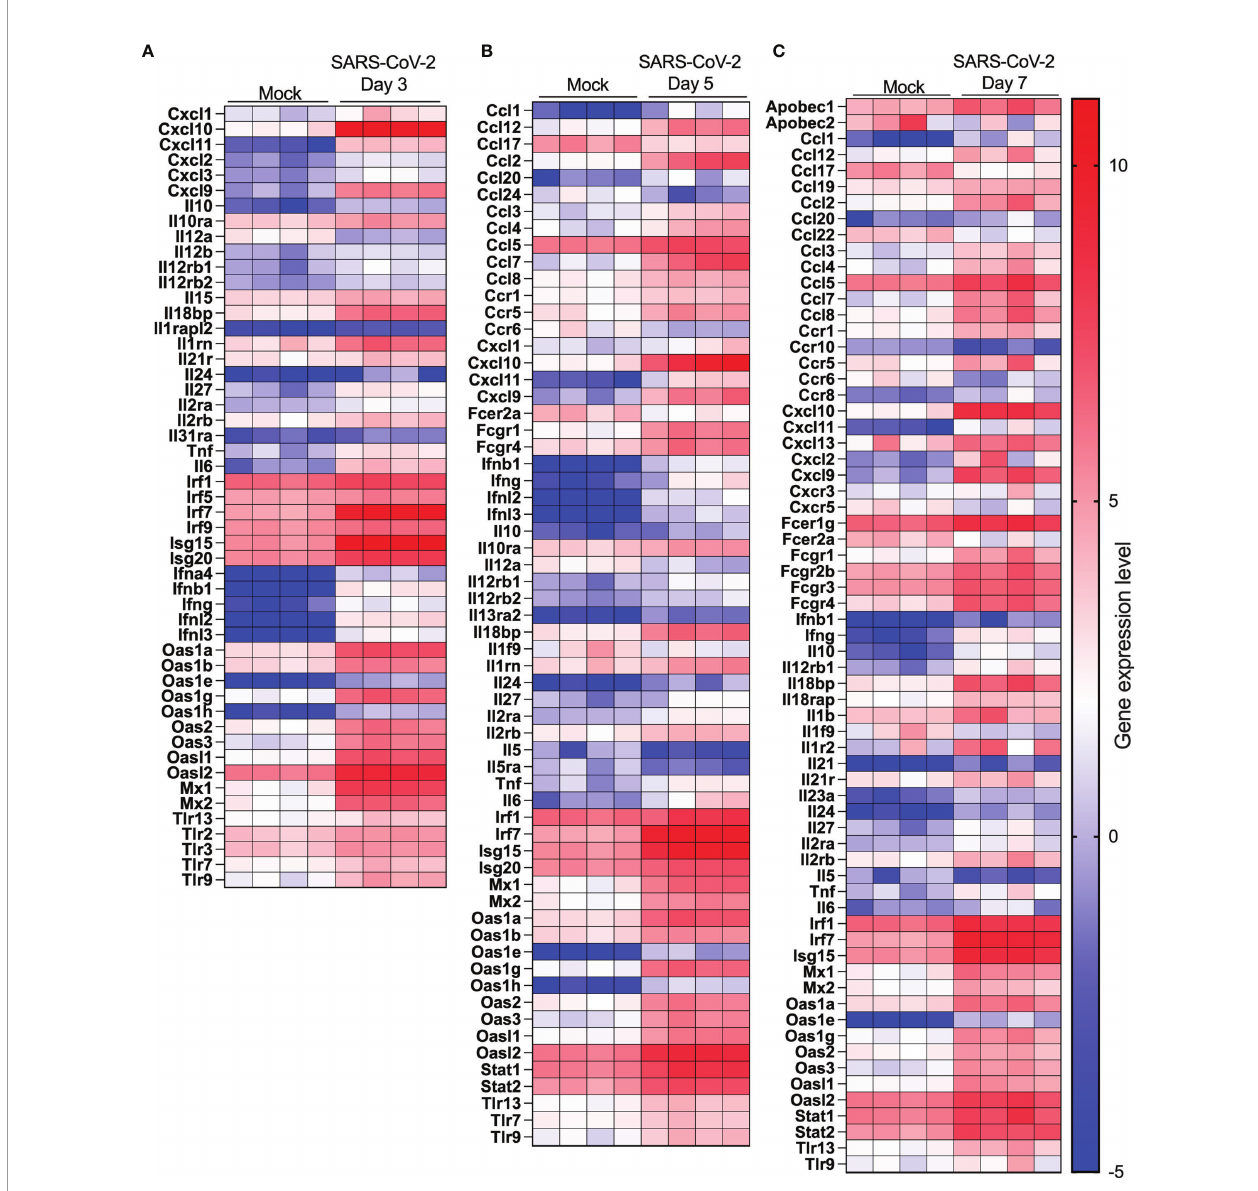
FIGURE 5 | Cytokine and IFN-related gene expression pro fi les in lungs of SARS-CoV-2 infected mice. RNA from lungs of mock-infected and SARS-CoV-2-infected mice was analyzed by RNA seq. (A-C) Heat map representation of genes encoding cytokines/chemokines, IFN or IFN-stimulated genes at day 3 (A) , day 5 (B) or day (7) post-infection or mock-infected